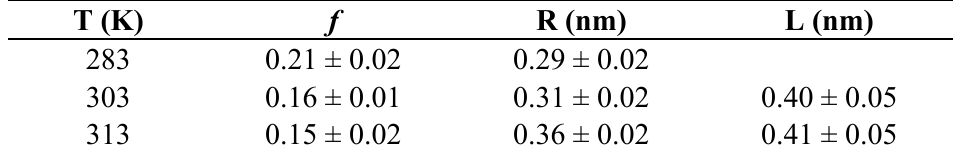
Table 5. Dynamical structural features of the polymer component by quasi-elastic neutron